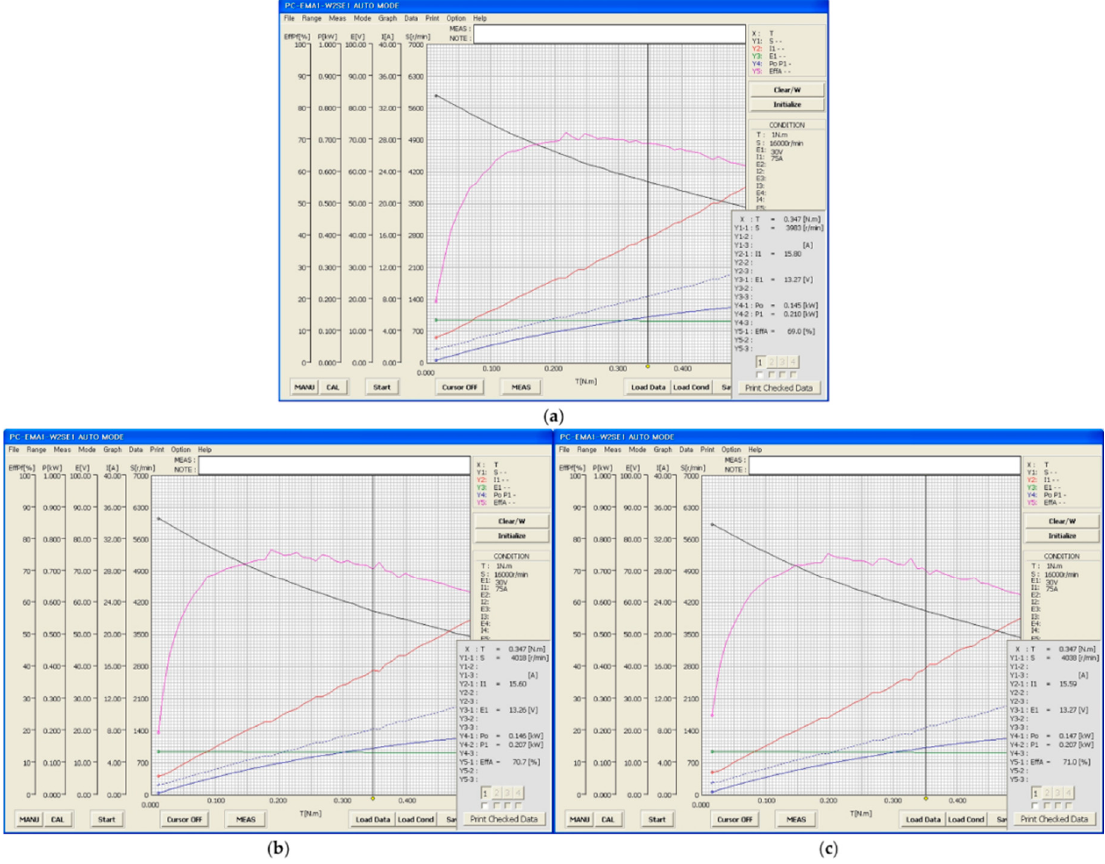
Figure 13. Comparison of experimental motor dynamometer test results: ( a ) Conventional; ( b ) DDO; ( c ) Proposed.